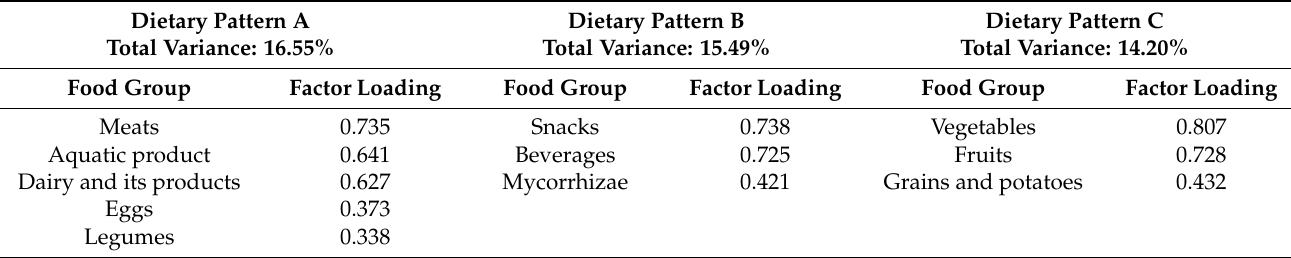
Table 2. Dietary patterns and factor loadings identified using factor